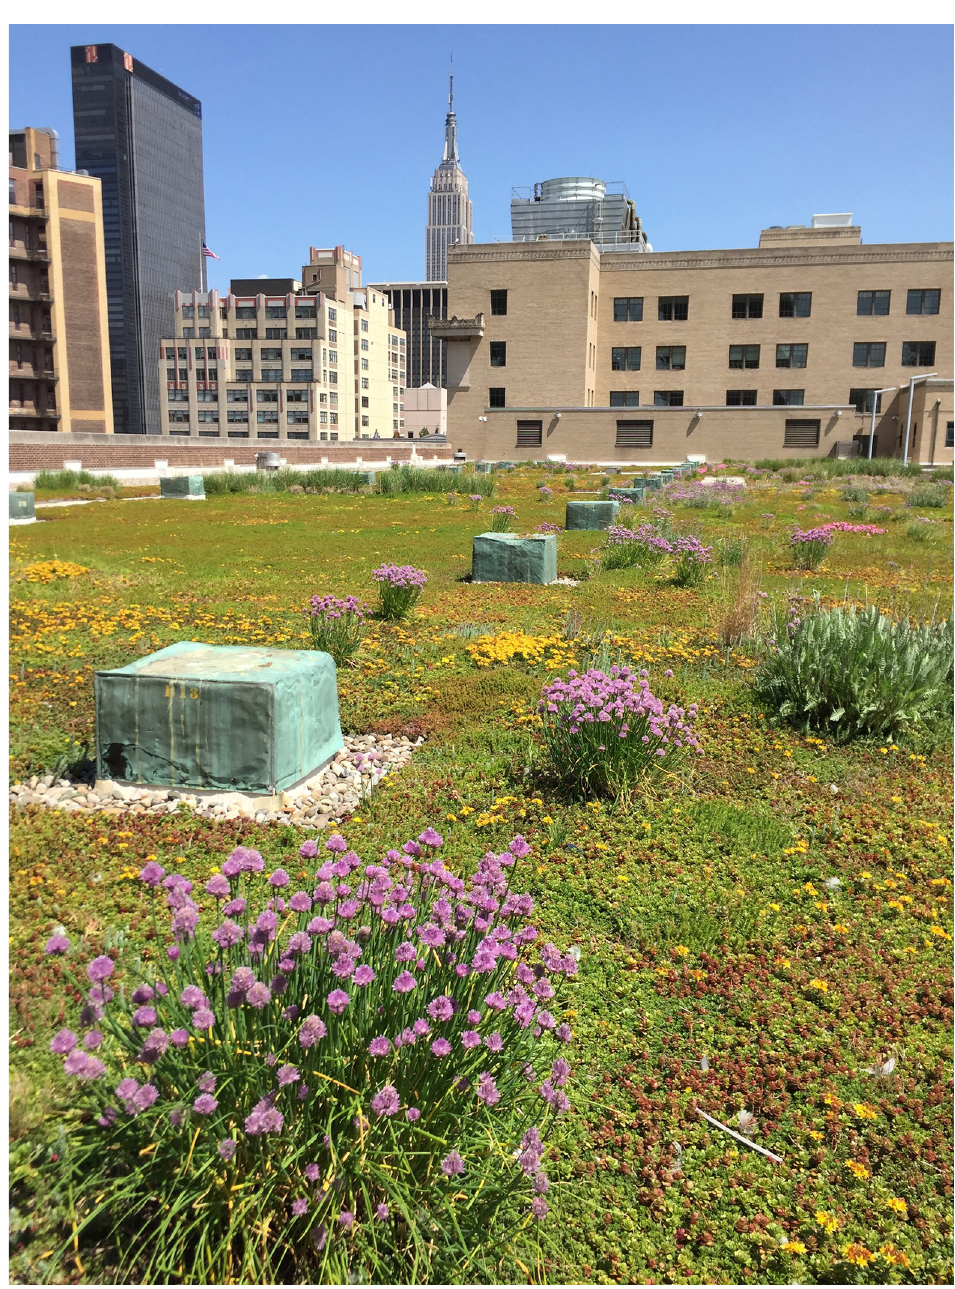
Fig 3. USPS. The green roof is located above the US Post Office’s Morgan Processing and Distribution Center in Manhattan, NYC.